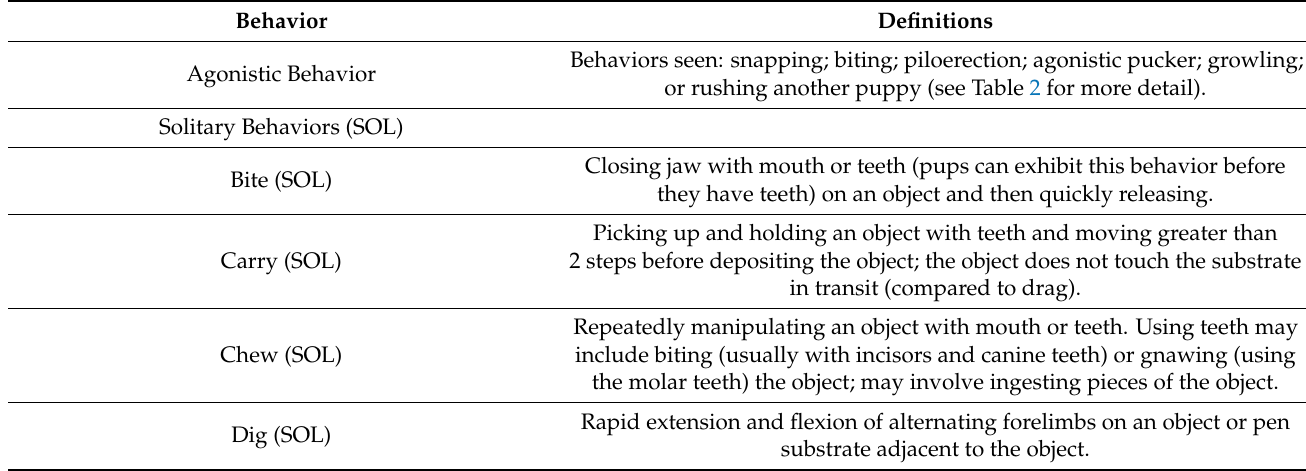
Table 1. Object Play Ethogram. Behaviors exhibited during interactions with objects. Each behavior is followed by noting the context in which the behavior in the ethogram occurs: only one animal engages in the behavior (solitary/SOL); two or more animals engage in the behavior